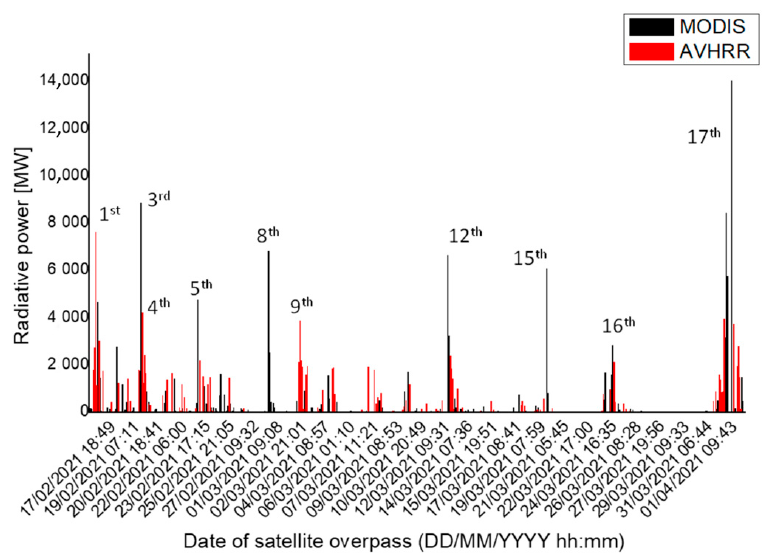
Figure 5. Temporal trend of radiative power retrieved from AVHRR (mean value from two end-members) and MODIS observations, starting from RST VOLC detections, with the indication of the Mt. Etna paroxysms.